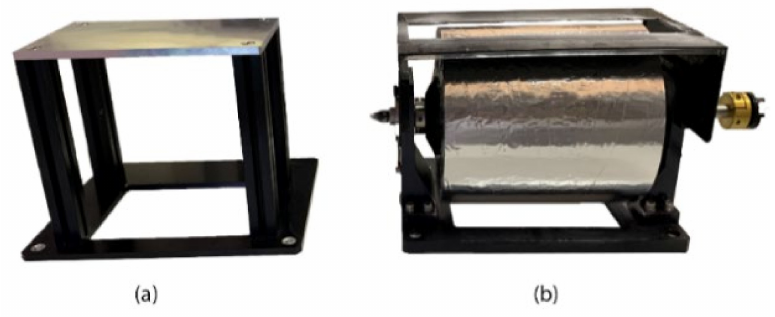
Figure 1. Types of collectors: ( a )—flat plate collector, ( b )—rotating drum